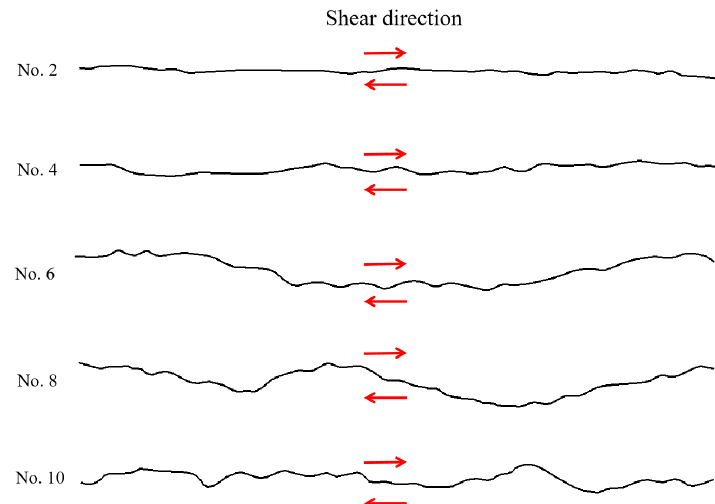
Figure 2. The shear directions for different joint profiles.